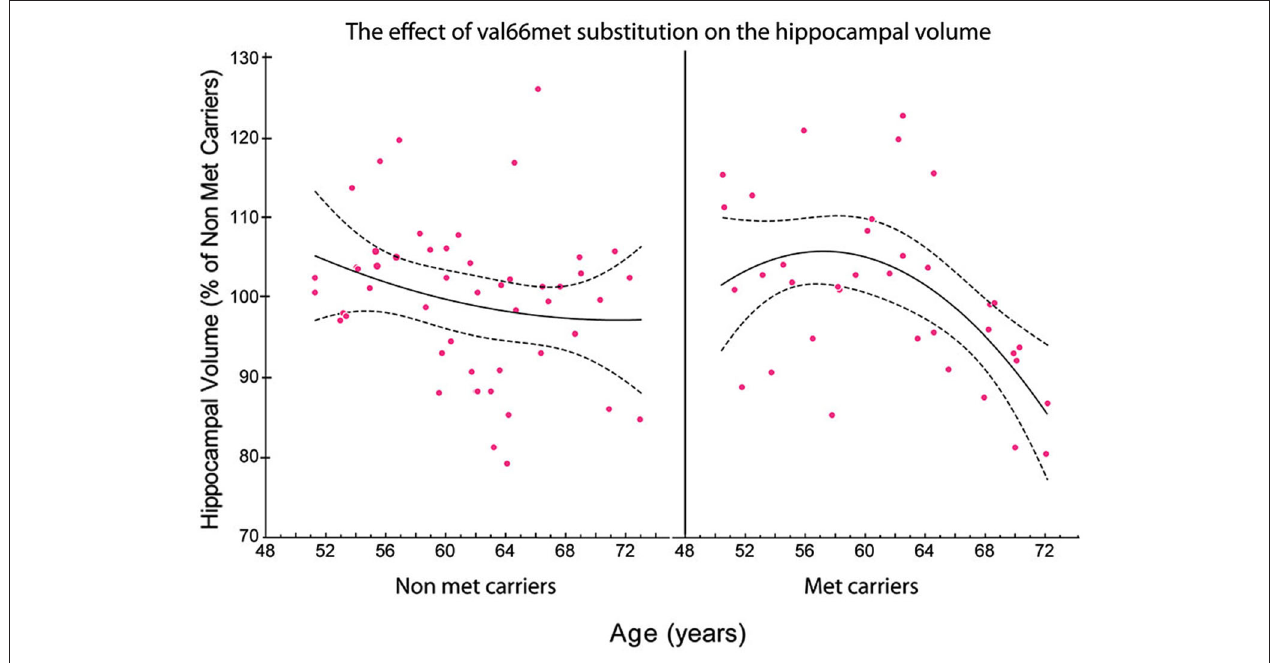
correlation was found in non-met carriers ( r = − 0.178, P = 0.2639). Furthermore, the slope of the regression in the hippocampal volume of met carriers (slope = − 0.038) was twice the value of the slope of regression in non-met carriers (slope = − 0.016; Published from Sanchez et al.,